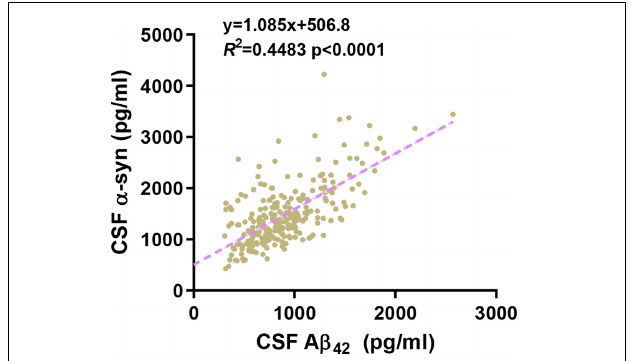
FIGURE 5 | Cerebrospinal fluid (CSF) α -syn levels correlated with A β 42